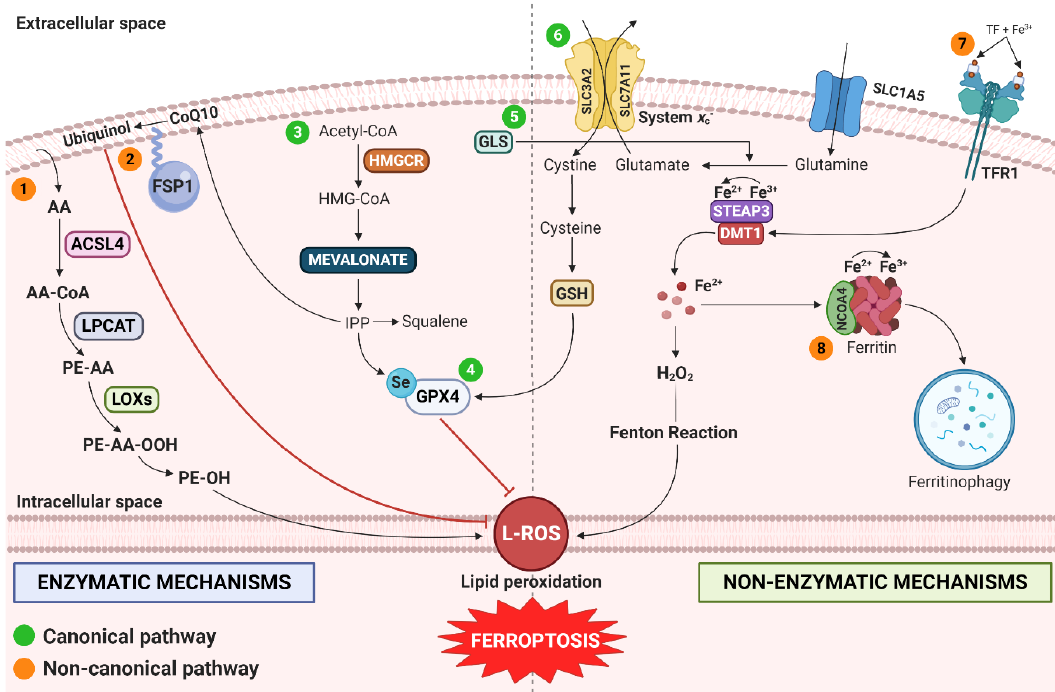
Figure 1. Regulatory metabolic pathways of ferroptosis. Metabolic pathways are divided into enzymatic (left panel) and non-enzymatic (right panel) mechanisms as well as into canonical (green dots) and non-canonical (orange dots). (1) Lipid metabolism pathway: AA and other PUFAs derived from lipid bilayers are metabolized by ACSL4 and LPCAT and then oxidized by LOXs to produce L-ROS. (2) FSP1-CoQ10-NADPH pathway: in plasma membrane, FSP1 reduces CoQ10 to ubiquinol which, in turn, blocks lipid peroxidation. (3) Mevalonate pathway: acetyl-CoA is converted